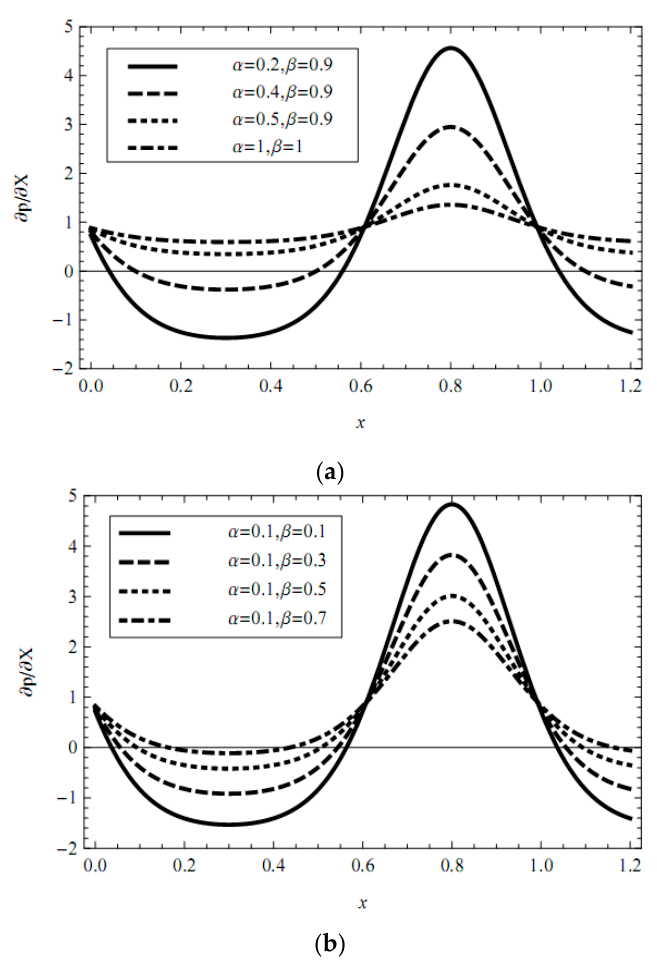
Figure 4. Profiles of the pressure gradient for various values of fractional operator parameter ( a ) α and ( b ) β with fixed λ 1 = 1, λ 2 = 1, m = 1, φ = 0.3, U HS = 1, Q = 0.1, t =